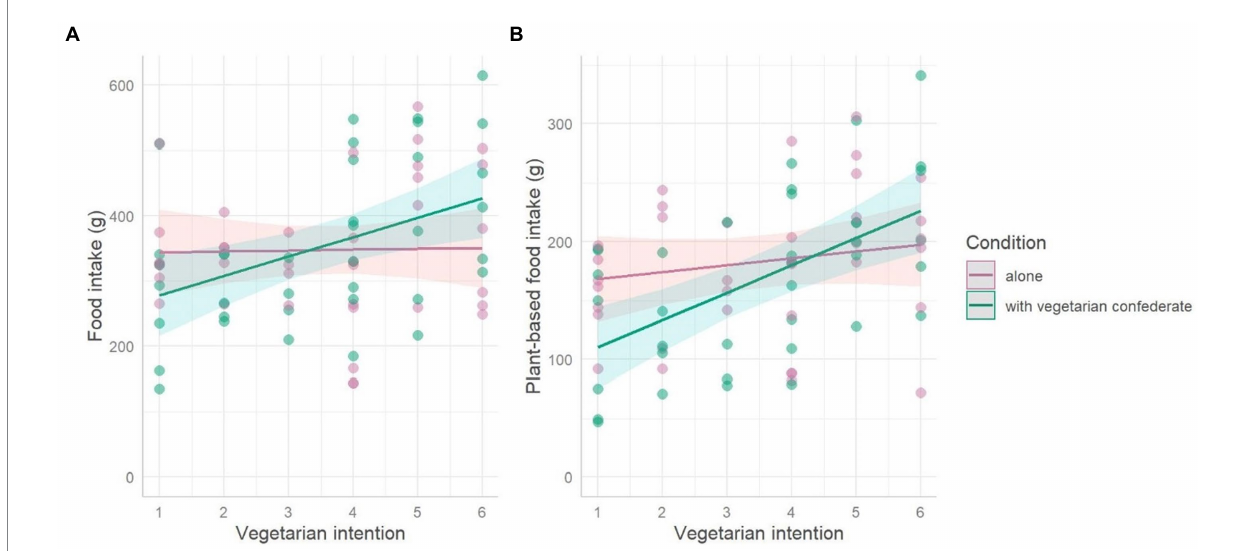
FIGURE 1 Low intentions to follow a vegetarian diet in the future result in a lower total (A) and plant foods (B) intakes in presence of a vegetarian confederate. The dots represent the data. The lines represent estimated slopes per study condition. Colored areas represent 95% confidence intervals based on estimated standard errors (+/ − 1.96